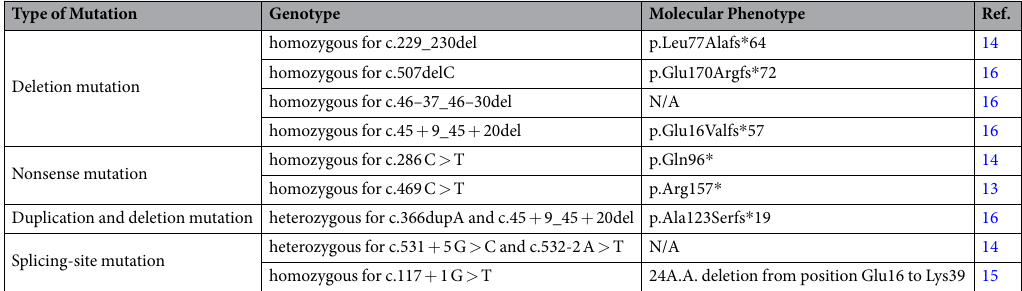
Table 2. Summary of KTS-associated ROGDI gene